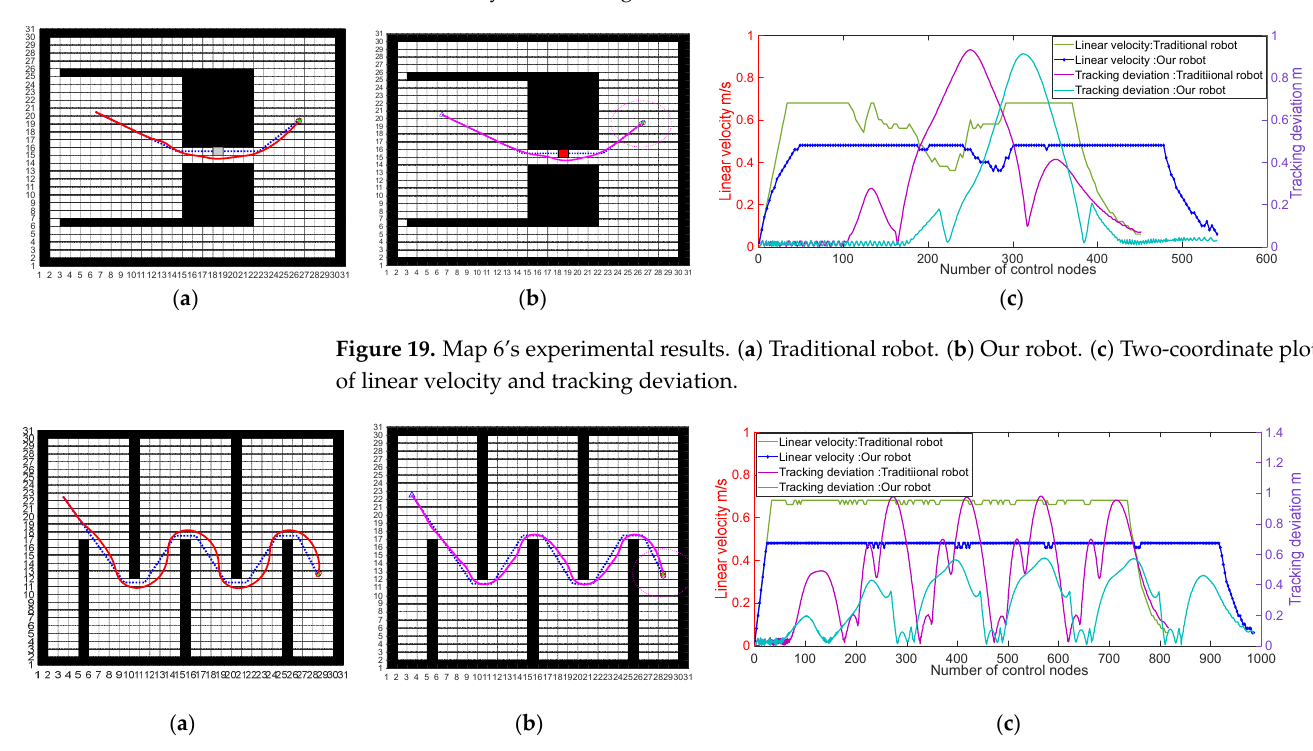
Figure 20. Map 7’s experimental results. ( a ) Traditional robot. ( b ) Our robot. ( c ) Two-coordinate plot of linear velocity and tracking deviation.